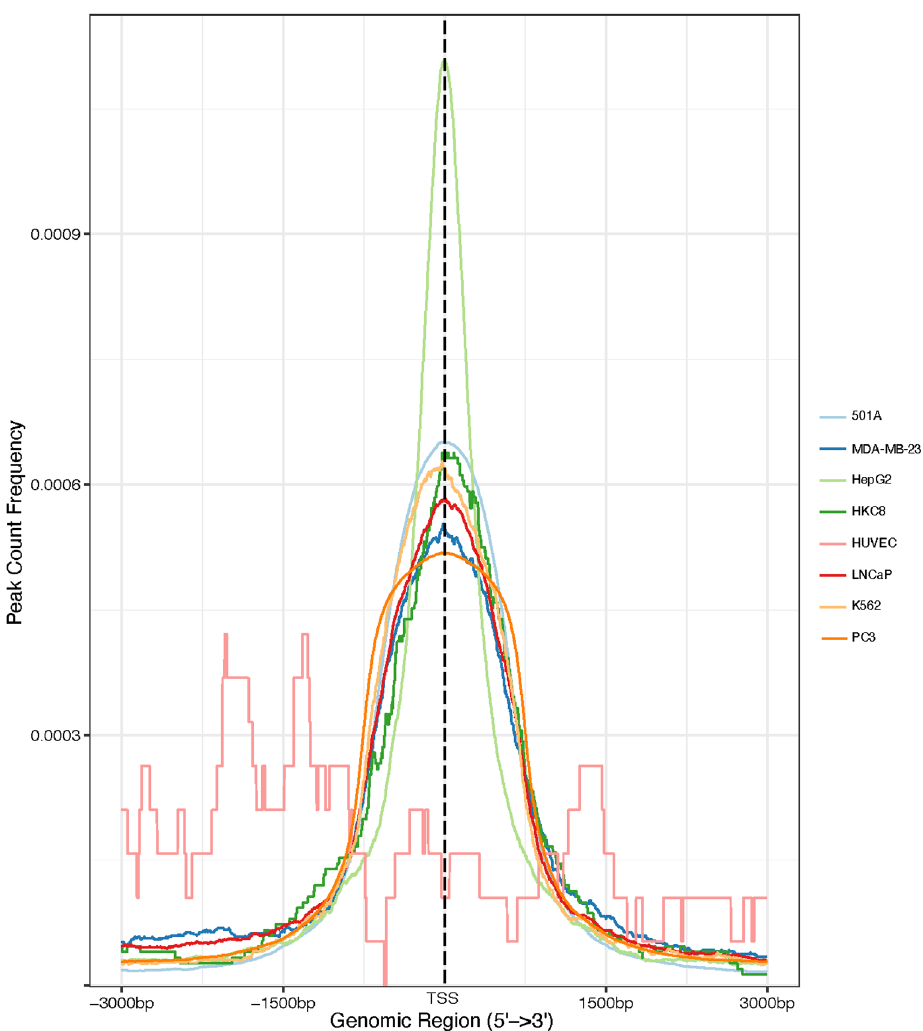
Figure 3. The distance of the HIF1A ChIP-seq peak regions to the proximal genes. Using the ChIPseeker tool, the HIF1A peaks were visualized in terms of their proximity to nearby